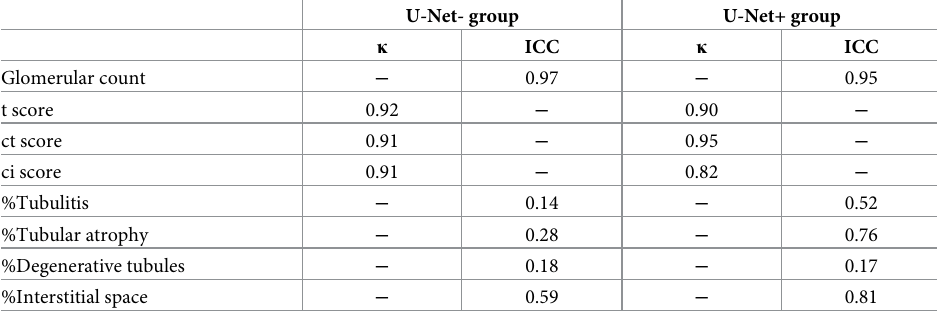
Table 6. Agreement ratios between renal pathologists with and without U-Net-segmented